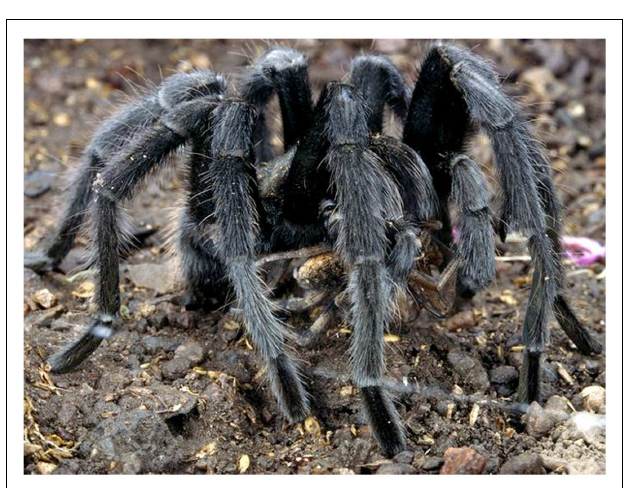
FIGURE 4 | Biophila and